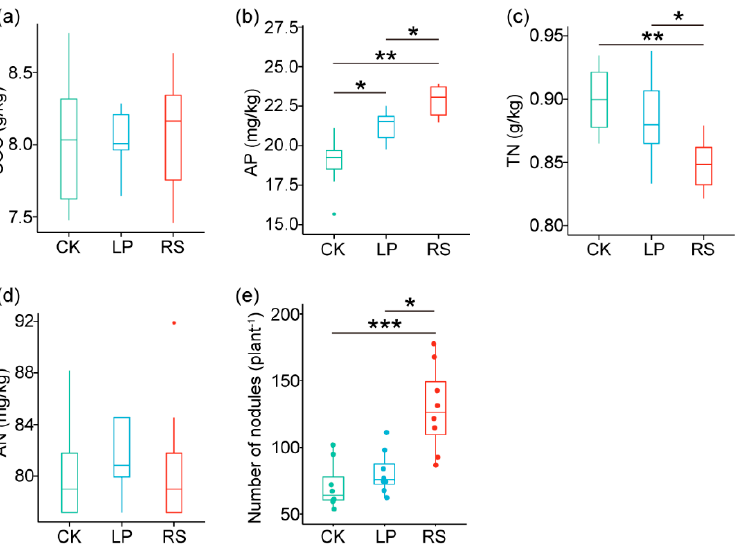
Figure 1. The effects of cover crops on soil properties: ( a ) soil organic carbon (SOC), ( b ) available phosphorus (AP), ( c ) total nitrogen (TN), ( d ), available nitrogen (AN), and ( e ) peanut nodulation (CK, no cover crop; LP, application of Lolium perenne L.; RS, application of Raphanus sativus L.; * p < 0.05; ** p < 0.01; *** p < 0.001).